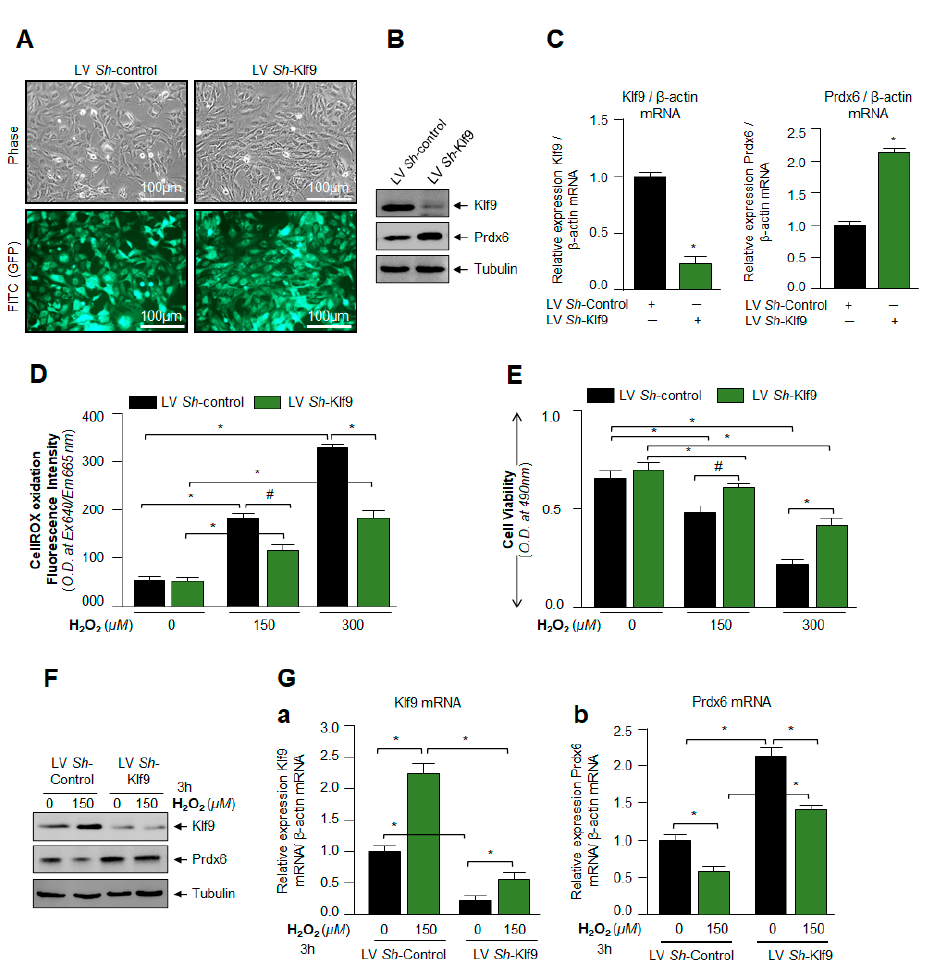
Figure 5. Klf9 gene knock down in hLECs showed elevated Prdx6 expression with reduced ROS and increased hLECs viability against oxidative stress. ( A – C ) hLECs were stably infected either with GFP (green fluorescence protein) linked lentiviral (LV) Sh -control or GFP linked LV Sh -Klf9 as described